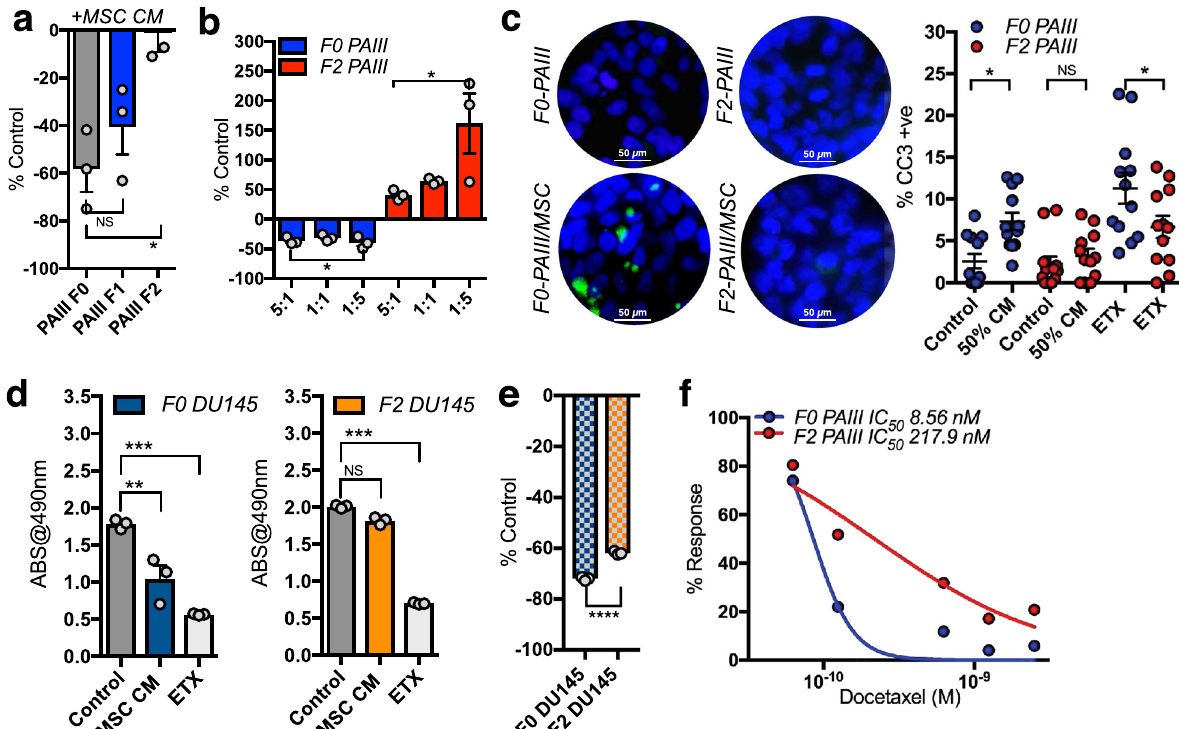
Fig. 3 MSCs select for apoptotic resistant prostate cancer cell populations. a Growth of parental PAIIIs (F0) and MSC PAIII cell lines selected after one (F1) or two rounds (F2) of exposure to MSC conditioned media (50% concentration). Cell growth was calculated as a percentage of controls grown in